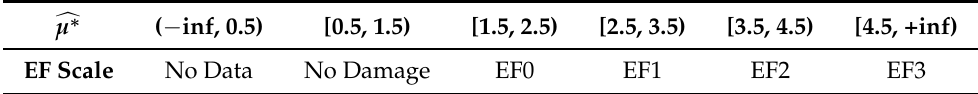
Table 4. EF scale